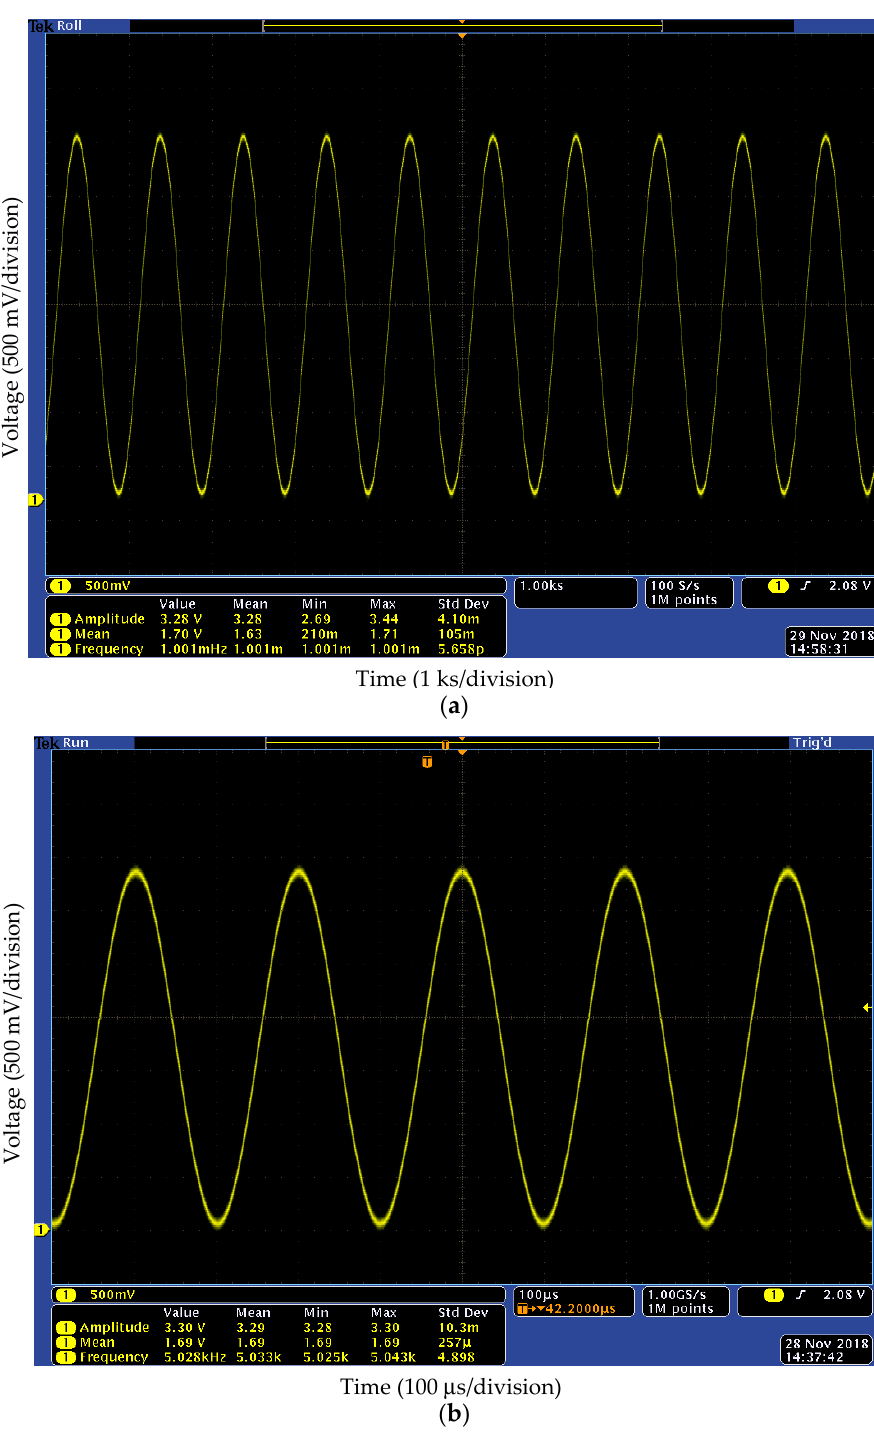
Figure 7. Sine signals (voltage versus time) generated after the corresponding PDM is low-pass filtered for the frequencies in the range of interest: ( a ) 1 mHz and ( b ) 5 kHz.